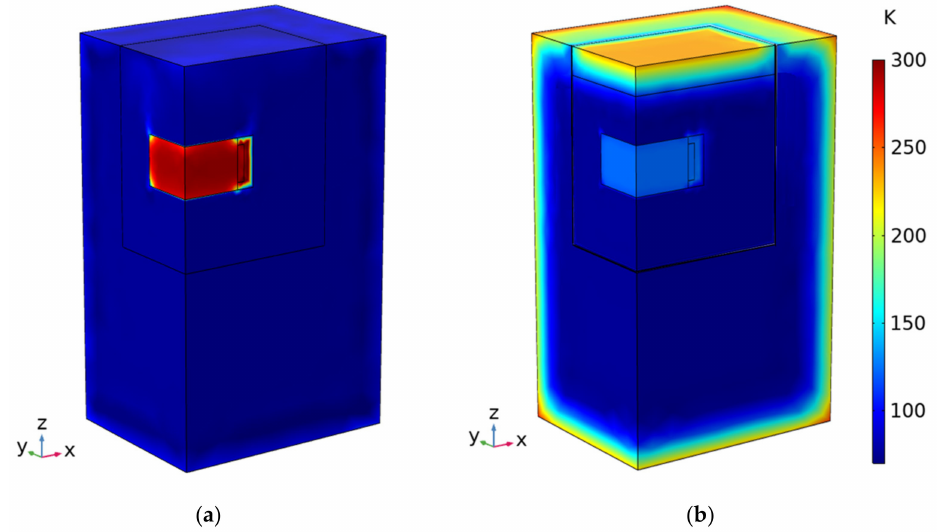
Figure 6. Temperature distribution at ( a ) t = 0.5 s and ( b ) t = 30 s. Figure 7a shows the obtained distribution of the heat flux and LN2 flow velocity streamlines from LN2 boiling at t = 0.5 s, when the generation of bubbles was intense just after the stepped transition. As one may verify, almost all the heat released from the YBCO bulk flew to the top surface open to the air. Figure 7b shows the distribution of heat flux and LN2 flow velocity streamlines at t = 30 s, when the heat release and rate of bubbling had decreased.